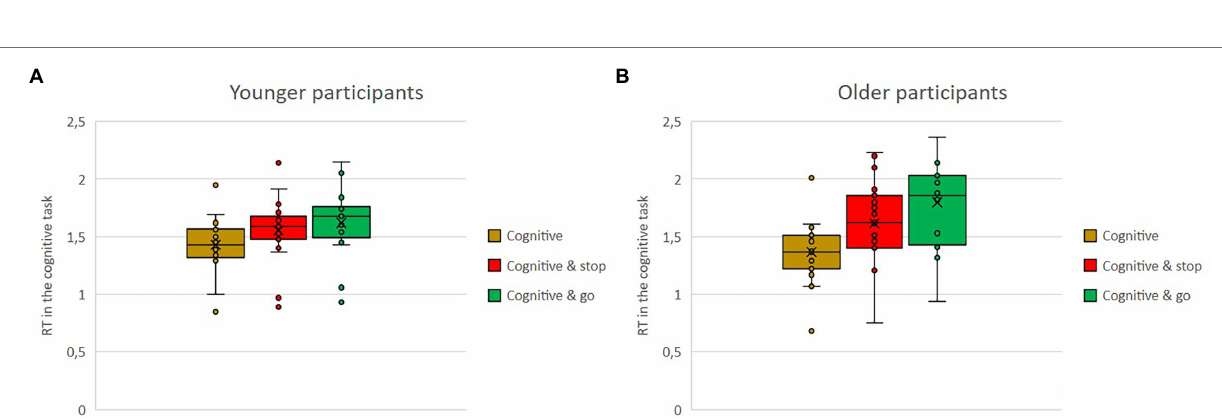
FIGURE 11 | (A,B) Means of response time in the cognitive secondary task, as single vs. dual-task conditions with either the stop or the go task for the older and the younger